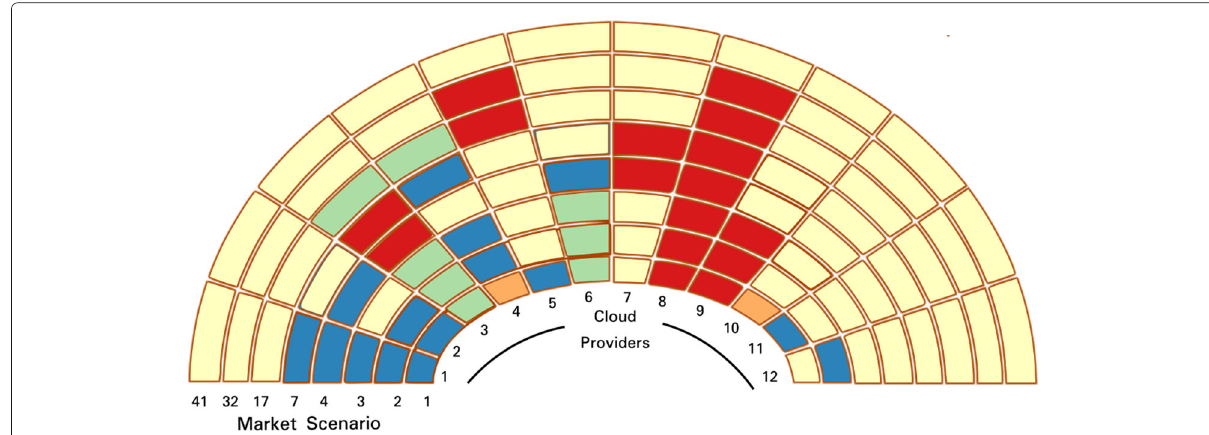
Fig. 2 Evolution of coalition structure with increasing price offers going from market scenario M 1 to M 45 (refer Eq.